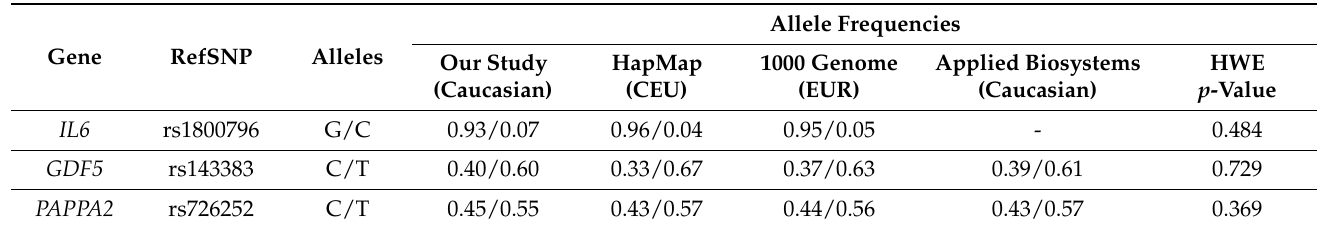
Table 1. Comparison of allelic frequencies and departure from HWE between our study and international databases.